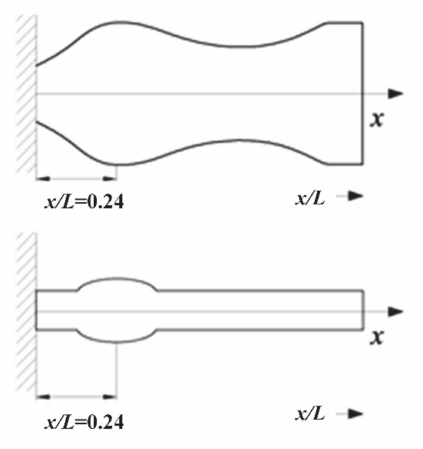
Figure 5. Optimal ( top ) versus simplified ( bottom ) cantilever configuration, where L is total cantilever length, x is the main coordinate.